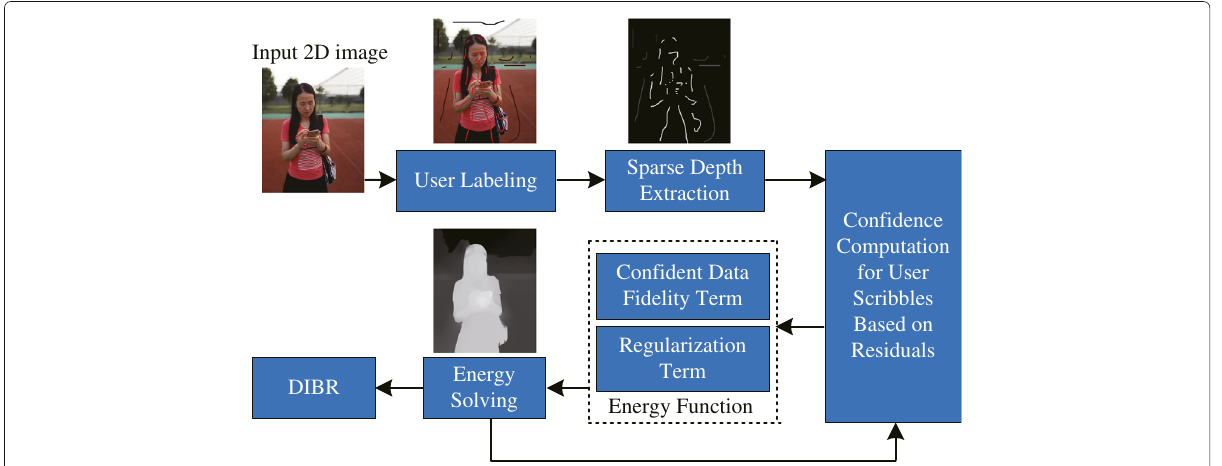
Fig. 2 A flowchart of the semi-automatic 2D-to-3D image conversion with the proposed method